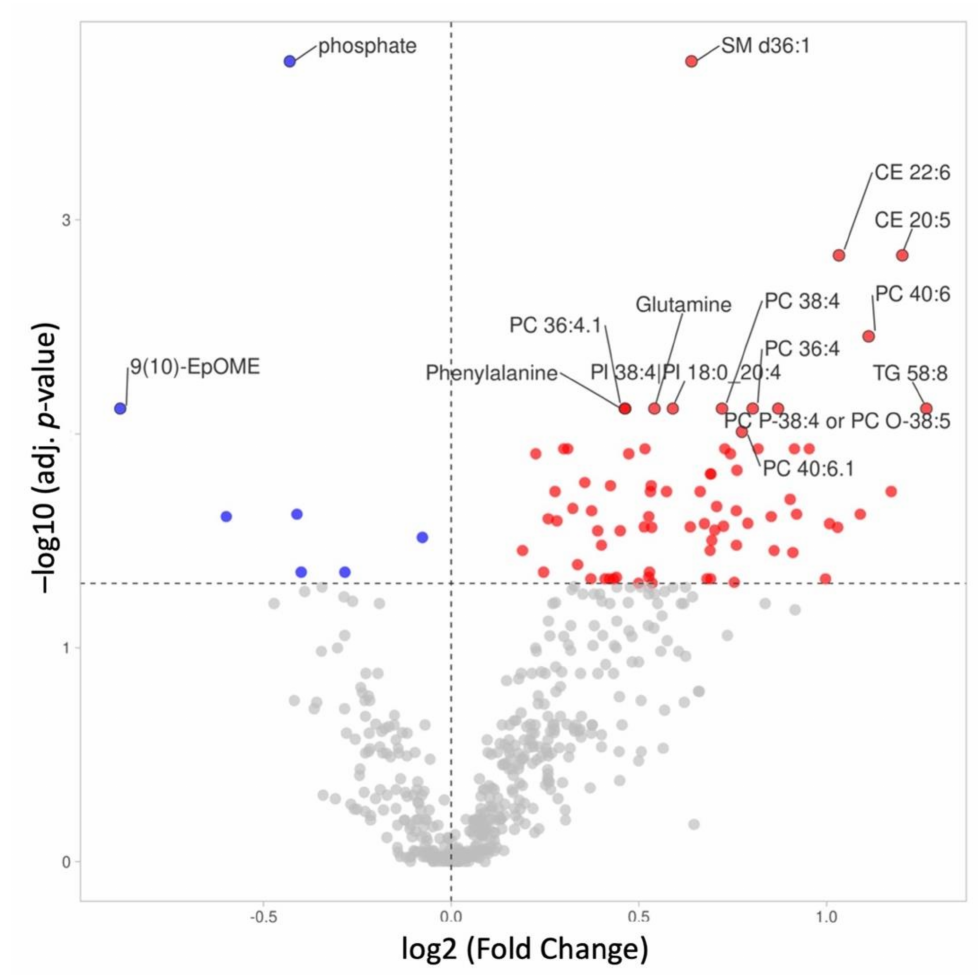
Figure 1. Volcano plot of metabolites across groups, with log-transformed adjusted p -values and fold changes. Red circles represent metabolites with increased expression in the obesity group. Blue circles represent metabolites with decreased expression in subjects with obesity. Grey circles represent non-significant metabolites (adjusted p -values ≥ 0.05). The top 15 top significant metabolites are labeled. SM, sphingomyelin; PC, phosphatidylcholine; CE, cholesteryl ester; TG, triacylglycerol; 9,10-EpOME, 9,10-epoxyoctadecenoic acid; PI,